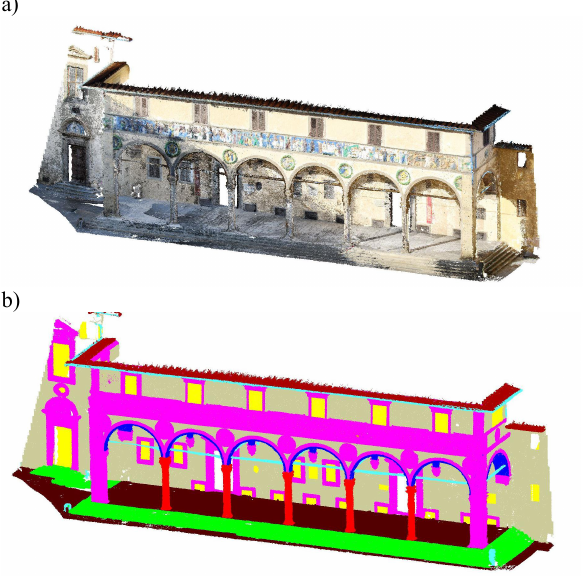
Figure 5 . a) RGB photogrammetry point cloud and b) corresponding labelled cloud of Spedale del Ceppo.